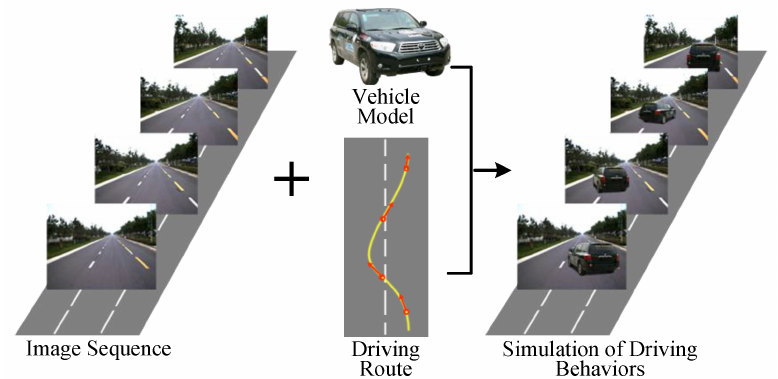
Figure 18. Simulation of driving behaviors with image sequences collected from real road environment (image obtained from